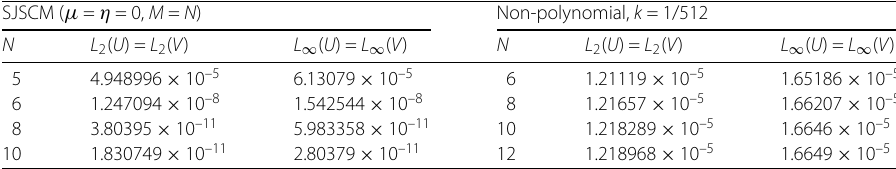
Table 19 L 2 and L ∞ error norms for u ( x , t ) = v ( x , t ) of Example 3 when 0 ≤ x ≤ 1, α 1 = α 2 = 0.4 SJSCM ( μ = η = 0, M = N ) Non-polynomial, k = 1/512